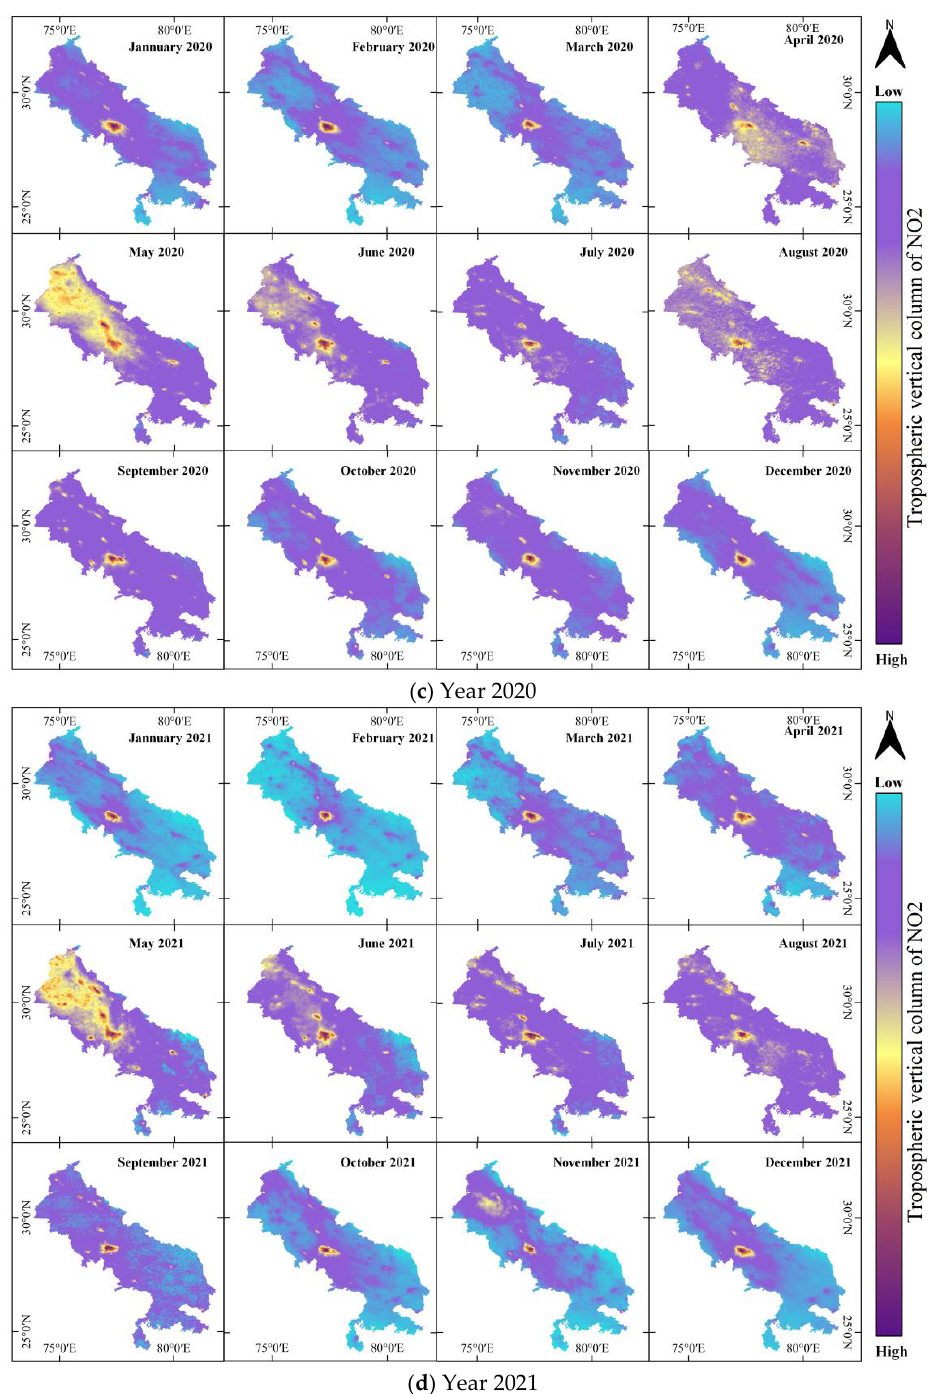
Figure 7. Atmospheric NO 2 concentration over the study site (June 2018 to December 2021).